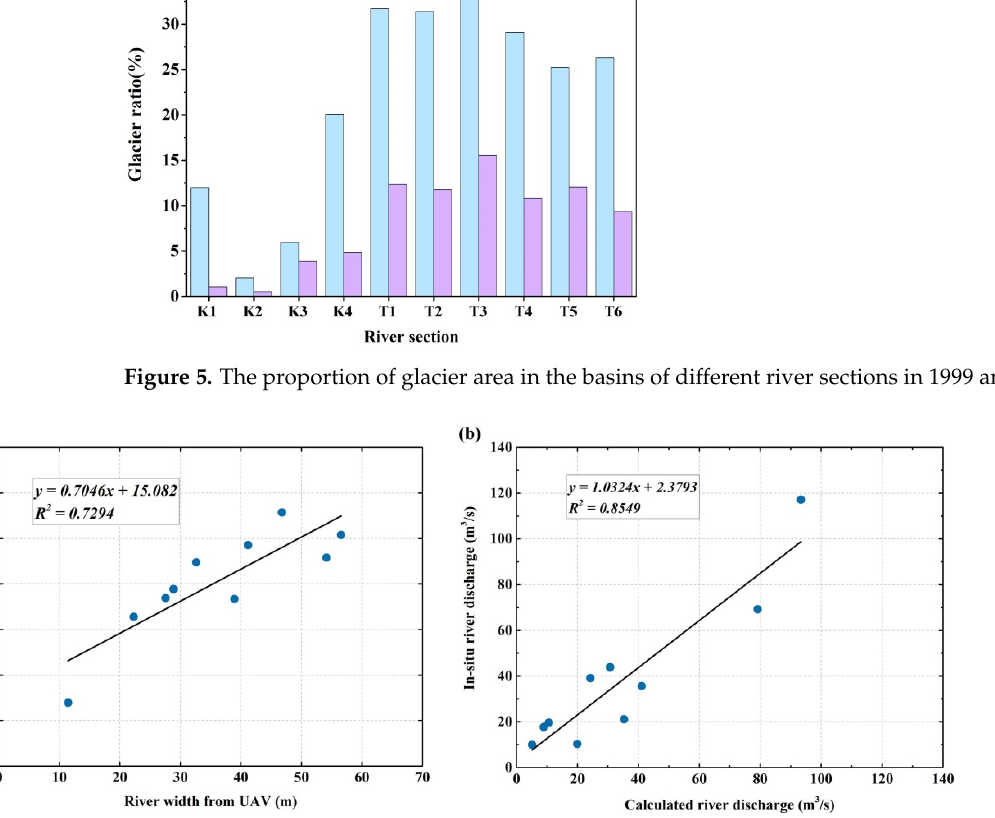
Figure 6. Validation of the calculated river width ( a ) and river discharge ( b ).